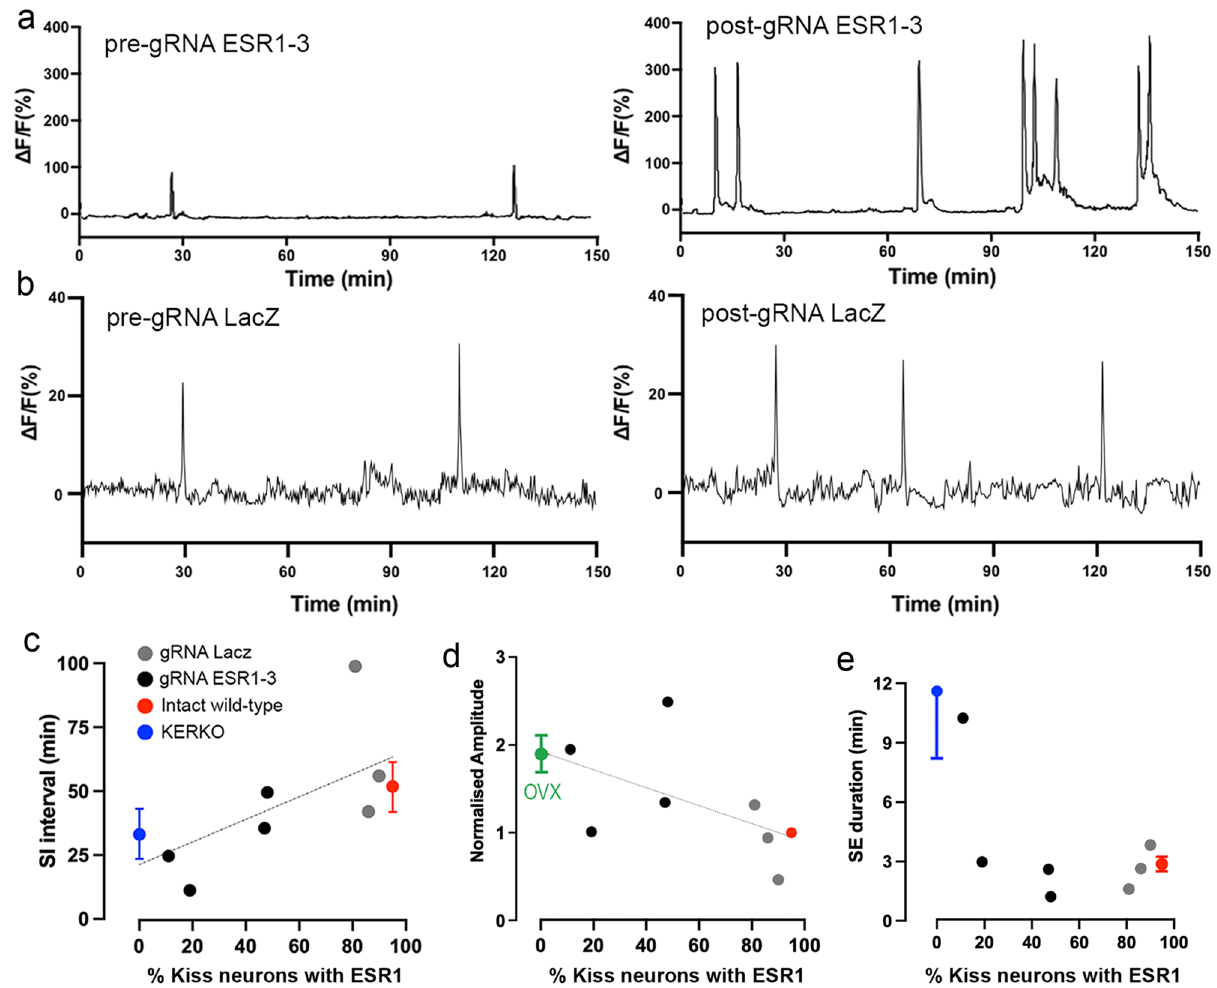
Fig. 8 | Effects of CRISPR knockdown of ESR1 on ARN KISS neuron synchroniza- tion events (SEs). a Photometry traces before and 3 weeks after infusion of gRNA ESR1-3 into the ARN. b Photometry traces before and 3 weeks after infusion of control gRNA LacZ into the ARN. c Individual SI intervals of SEs from mice given gRNA LacZ (gray, N =3), gRNA ESR1-3 (black, N =4) and, for comparison, the mean±SEM values for the same parameter recorded from intact wild-type (red) and KERKO (blue) mice plotted against the percentage of ARN KISS neurons